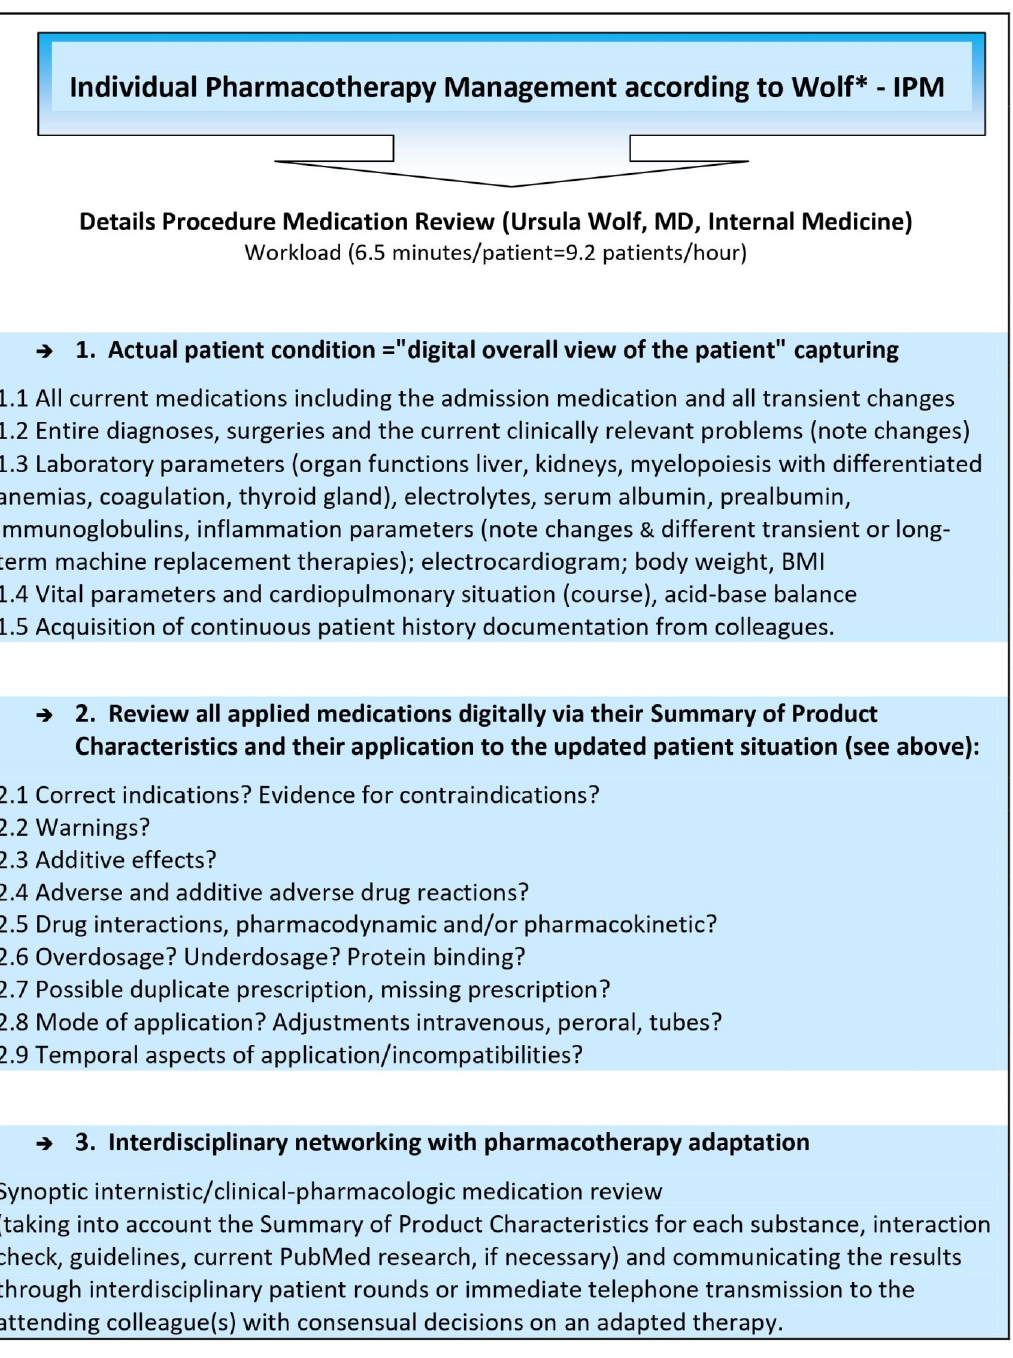
Figure 1. Comprehensive, reproducible IPM based on the hospital’s digital patient record. * Com-